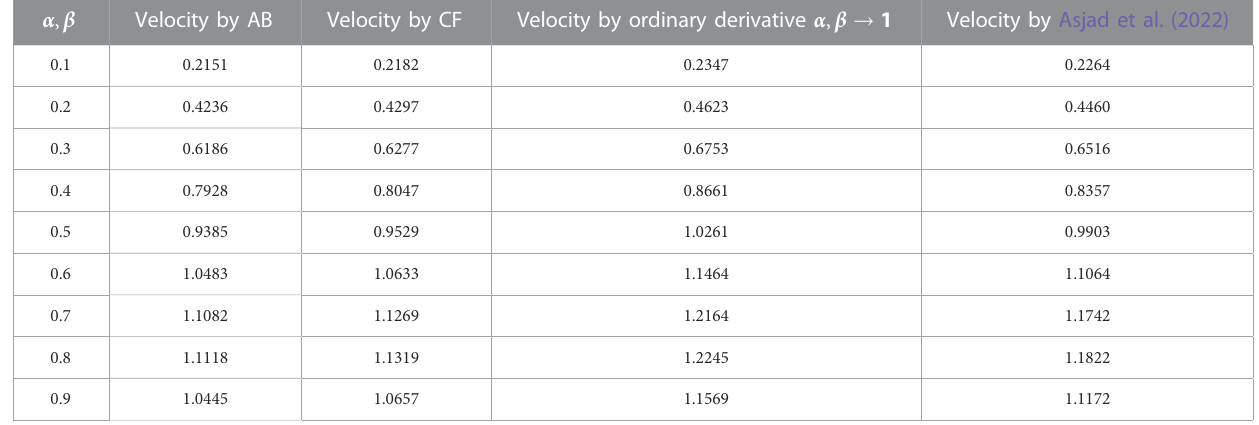
TABLE 6 Numerical analysis of attained results with the ordinary derivative and Asjad et al. (2022). α , β Velocity by AB Velocity by CF Velocity by ordinary derivative α , β →